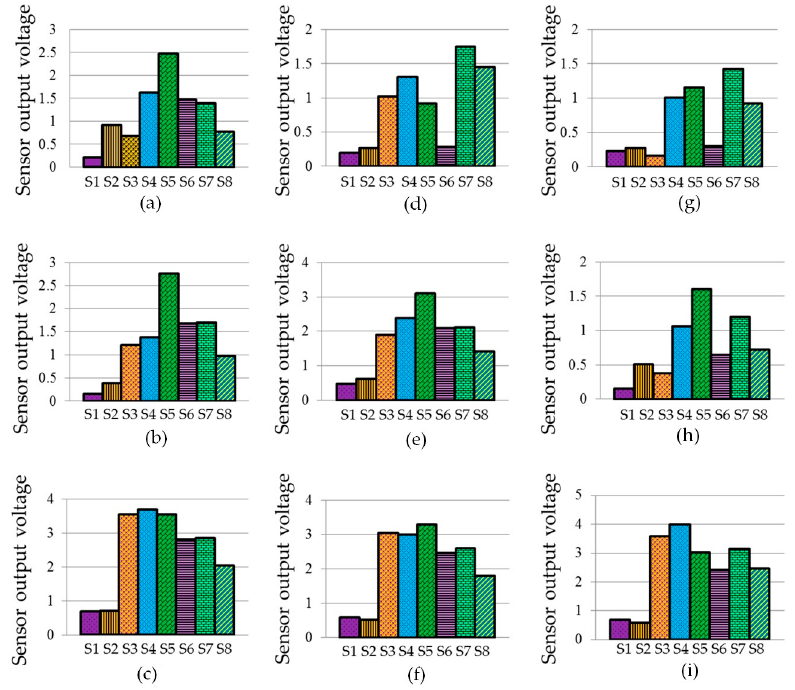
Figure 9. Signature patterns of the means of three types of fruits at three ripeness states: ( a ) green banana; ( b ) ripe banana; ( c ) rotten banana; ( d ) green sapodilla; ( e ) ripe sapodilla; ( f ) rotten sapodilla; ( g ) green pineapple; ( h ) ripe pineapple, and ( i ) rotten